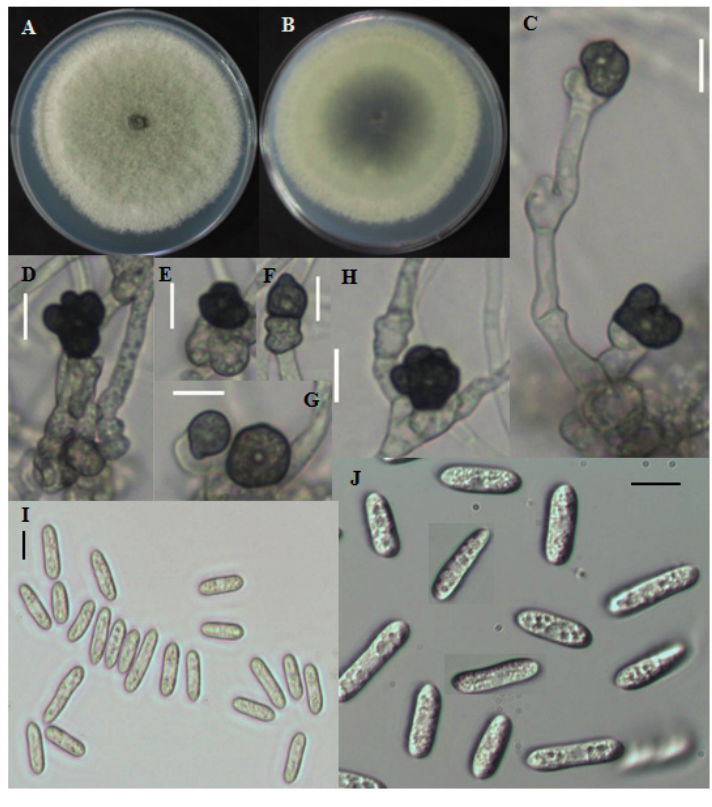
Figure 3. Morphological features of Colletotrichum fructicola CNU122031. Colony morphology in PDA after 7 days of inoculation at 25 °C ( A , obverse; B , Reverse); C – H : appresoria; I , J : Conidia (scale bars C – J = 10 μ